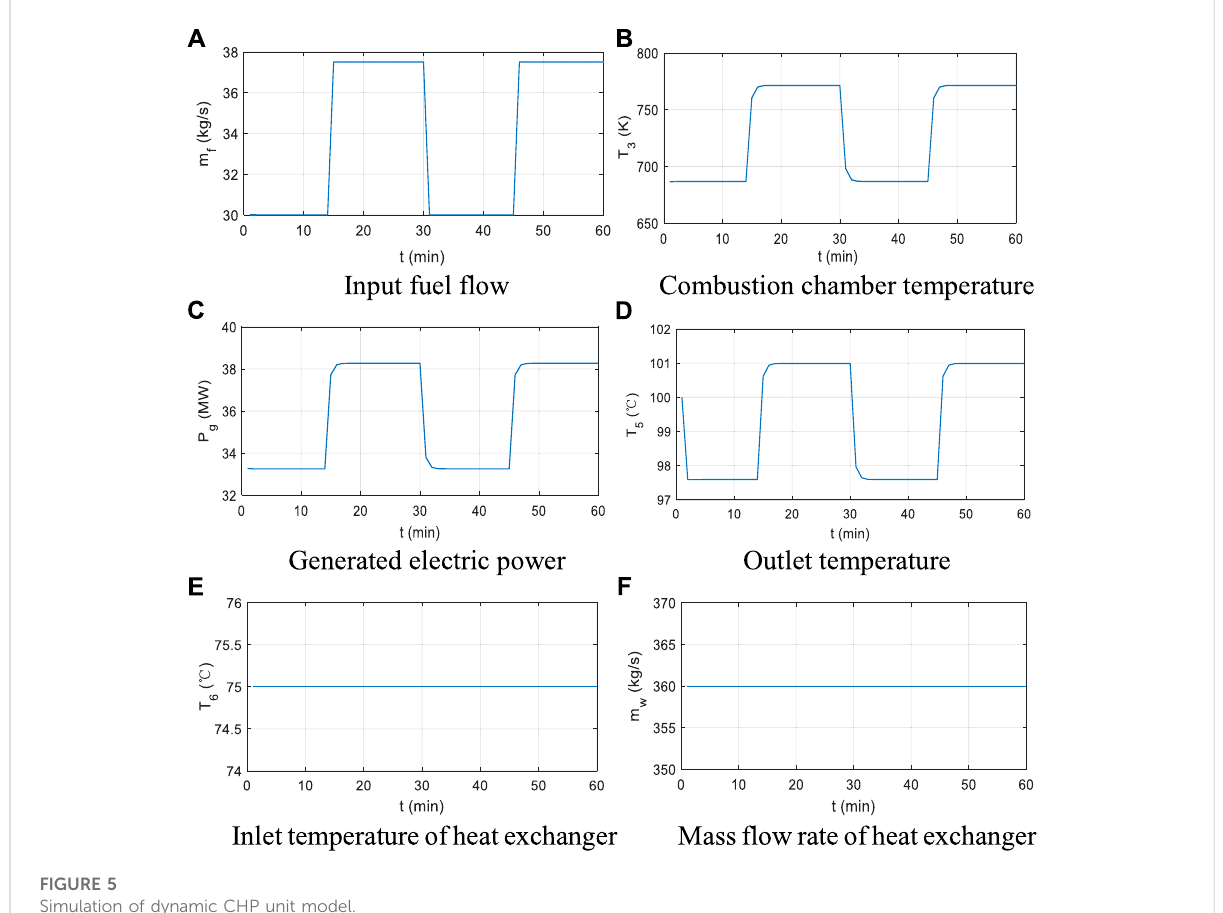
FIGURE 5 Simulation of dynamic CHP unit model.